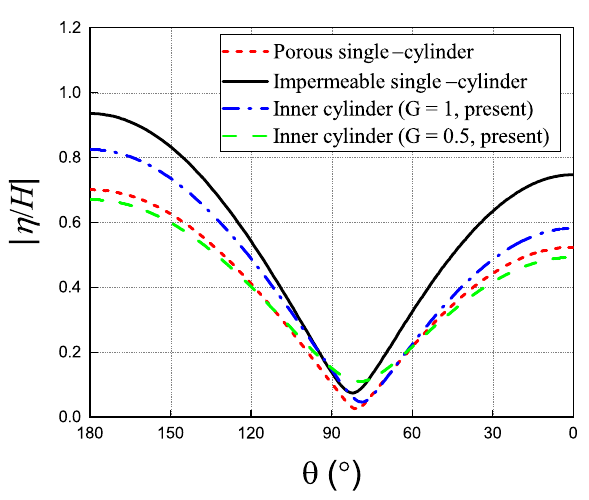
Figure 15. Comparison of wave run-ups between the single cylinder and the inner cylinder of the